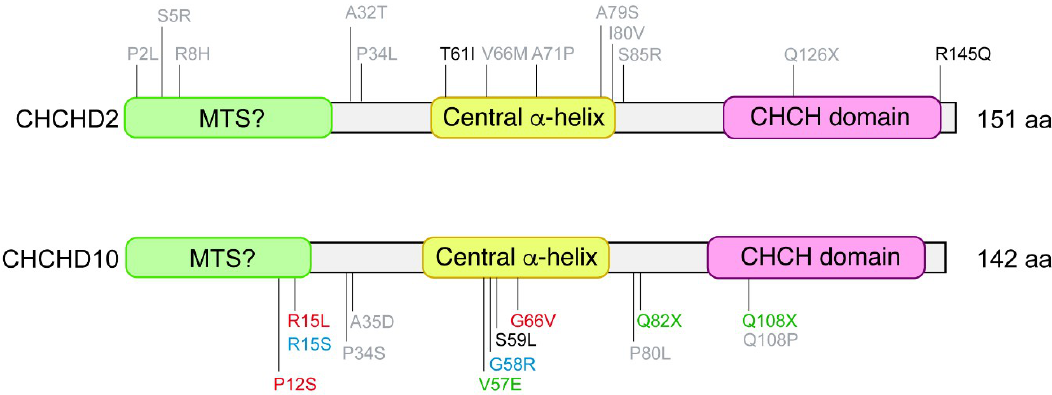
Figure 2. Representative disease-associated variants in the coding regions of CHCHD2 and CHCHD10. ( Upper ) Coding variants in PD patients are in black [7,30,31]. Potential risk variants found in PD [7,17, 30,32–37], DLB [32], AD [38,39], FTD [39], and MSA [40] patients without family history or sporadic cases are in gray. CHCHD2 T61I has been found in multiple families and has the greatest evidence for pathogenicity while R145Q has only been reported in the first case from familial PD population.